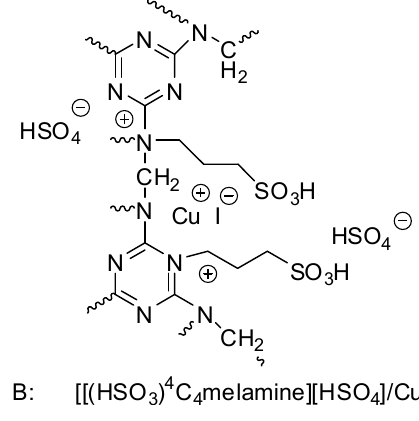
Figure 2. Supported ILs with both Lewis acidic and Brønsted acidic